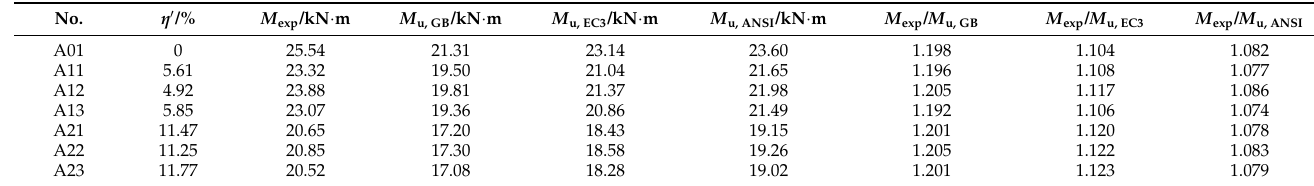
Table 5. Comparison of Test Results and Code